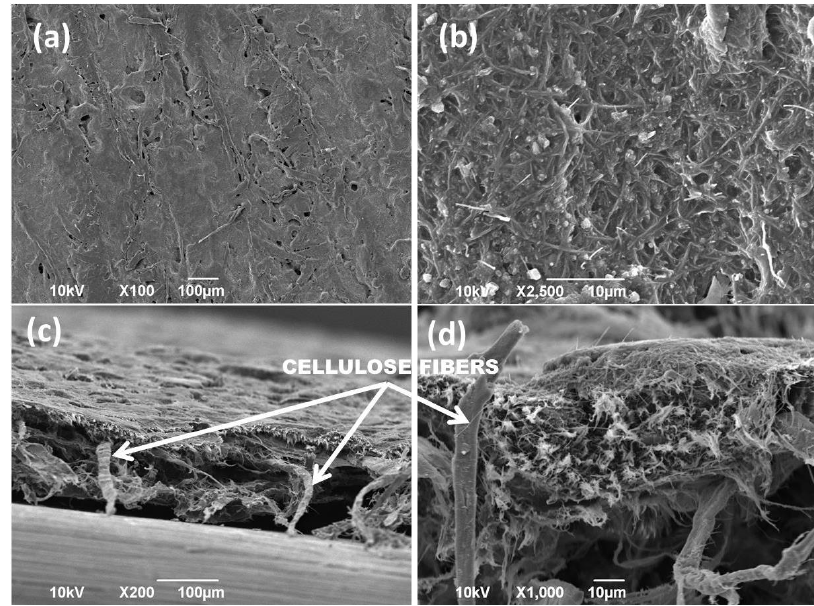
Figure 5. ( a ) and ( b ) Top surface SEM images of 20 wt % SCCNT containing biocomposite flexible Figure 5. ( a , b ) Top surface SEM images of 20 wt % SCCNT containing biocomposite flexible papers papers impregnated into cellulosic tissues by hydraulic pressing. Images ( c ) and ( d ) show the impregnated into cellulosic tissues by hydraulic pressing. Images ( c , d ) show the cross-section of the cross-section of the paper obtained by breaking the liquid nitrogen frozen paper into two pieces. paper obtained by breaking the liquid nitrogen frozen paper into two